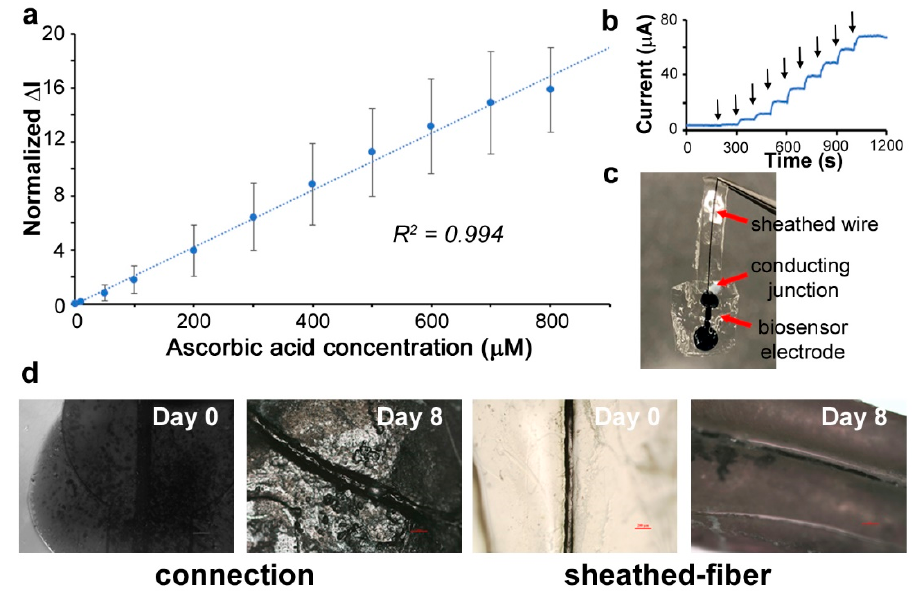
Figure 7. ( a ) Calibration curve for the addition of ascorbic acid. The normalized current response versus the addition of ascorbic acid is shown (three different sensors were tested and the average shown). ( b ) Chronoamperometric addition of ascorbic acid over time (added every 100 s) corresponding to the curve in ( a ). ( c ) Flexible biosensor with the micropatterned organic electrode connected to the core–sheath PEDOT:PSS wire. ( d ) The entire organic device may be controllably degraded.